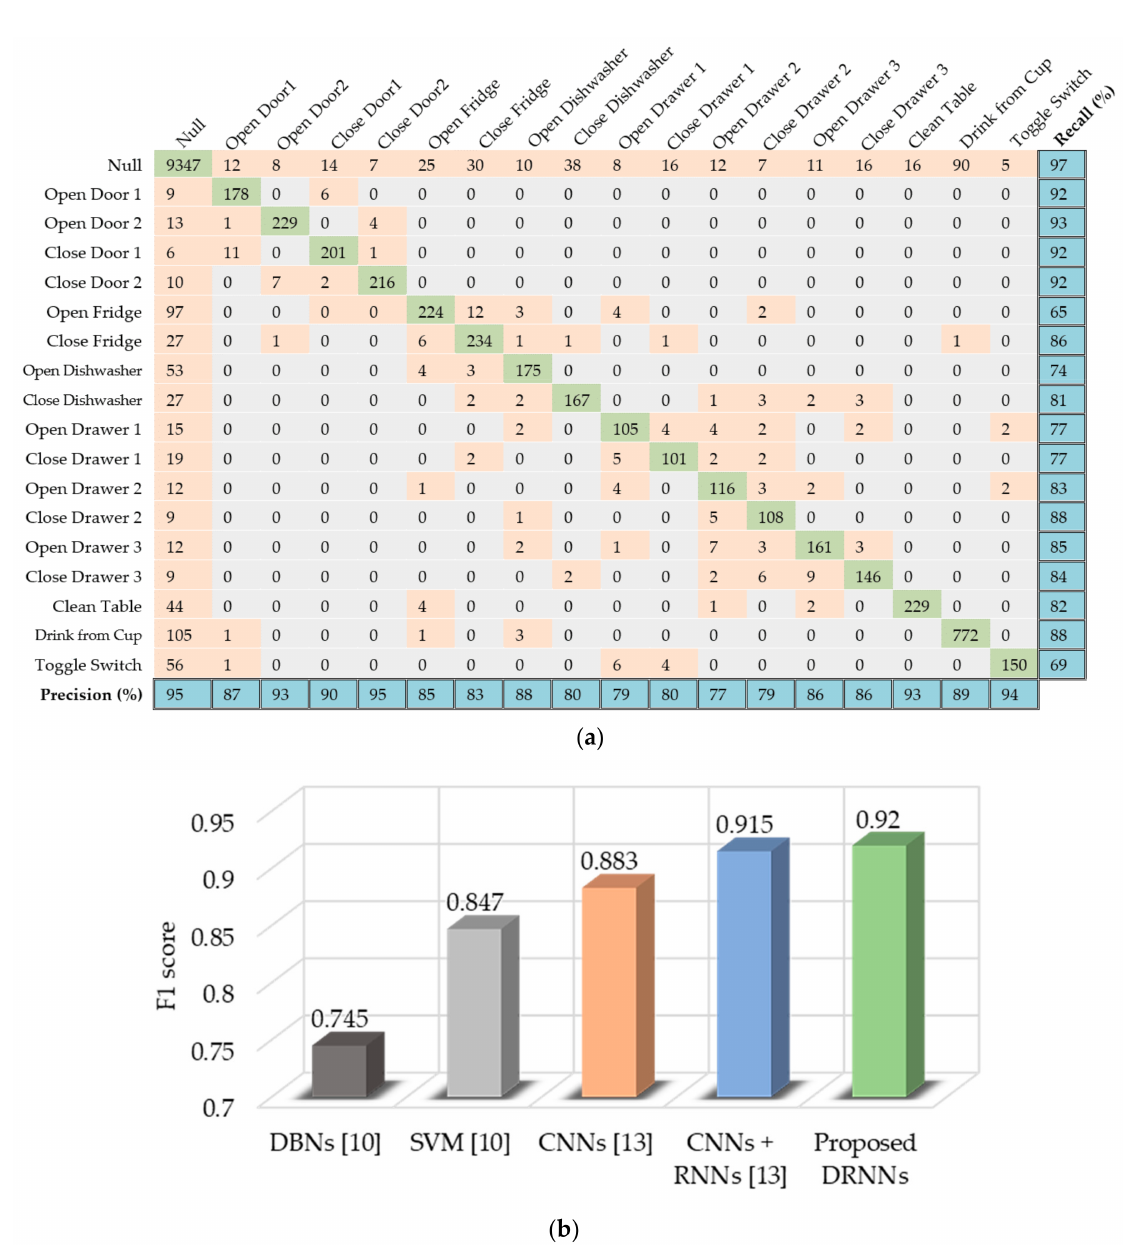
Figure 10. Performance results of the proposed bidirectional DRNN model for the Opportunity dataset: ( a ) Confusion matrix for the test set as well as per-class precision and recall results; ( b ) Comparative F1 score of proposed model against other